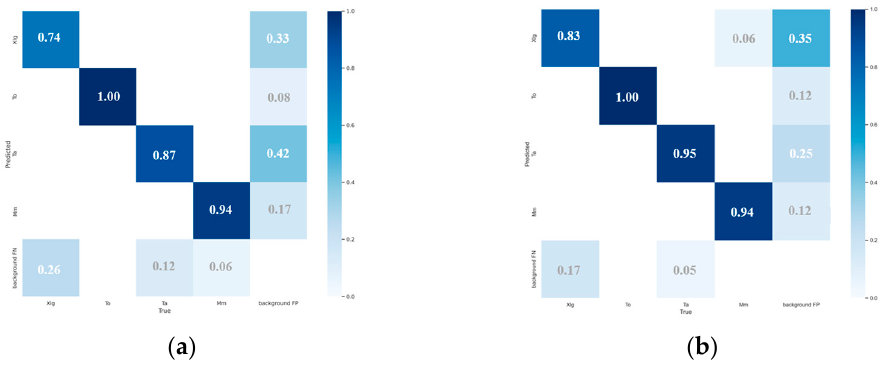
Figure 7. The confusion matrices of YOLO v3 and Tuna-YOLO. ( a , b ), respectively, represent the confusion matrix of original YOLO v3 and Tuna-YOLO.